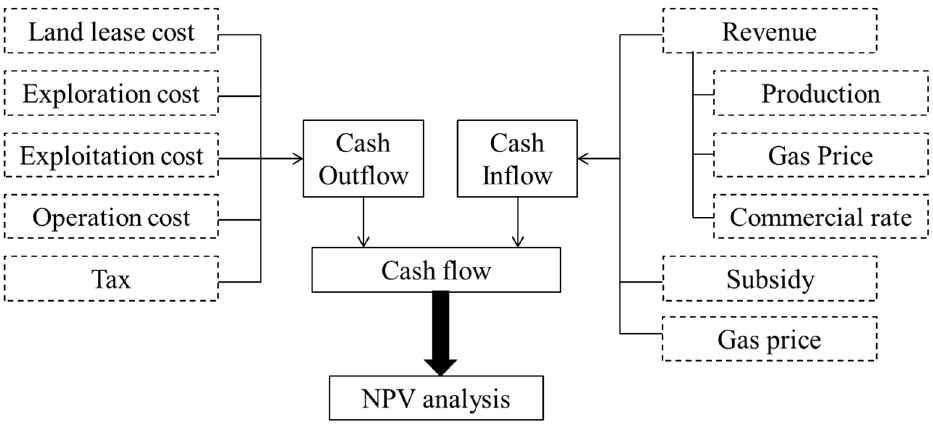
Figure 1. Workflow of breakeven analysis.